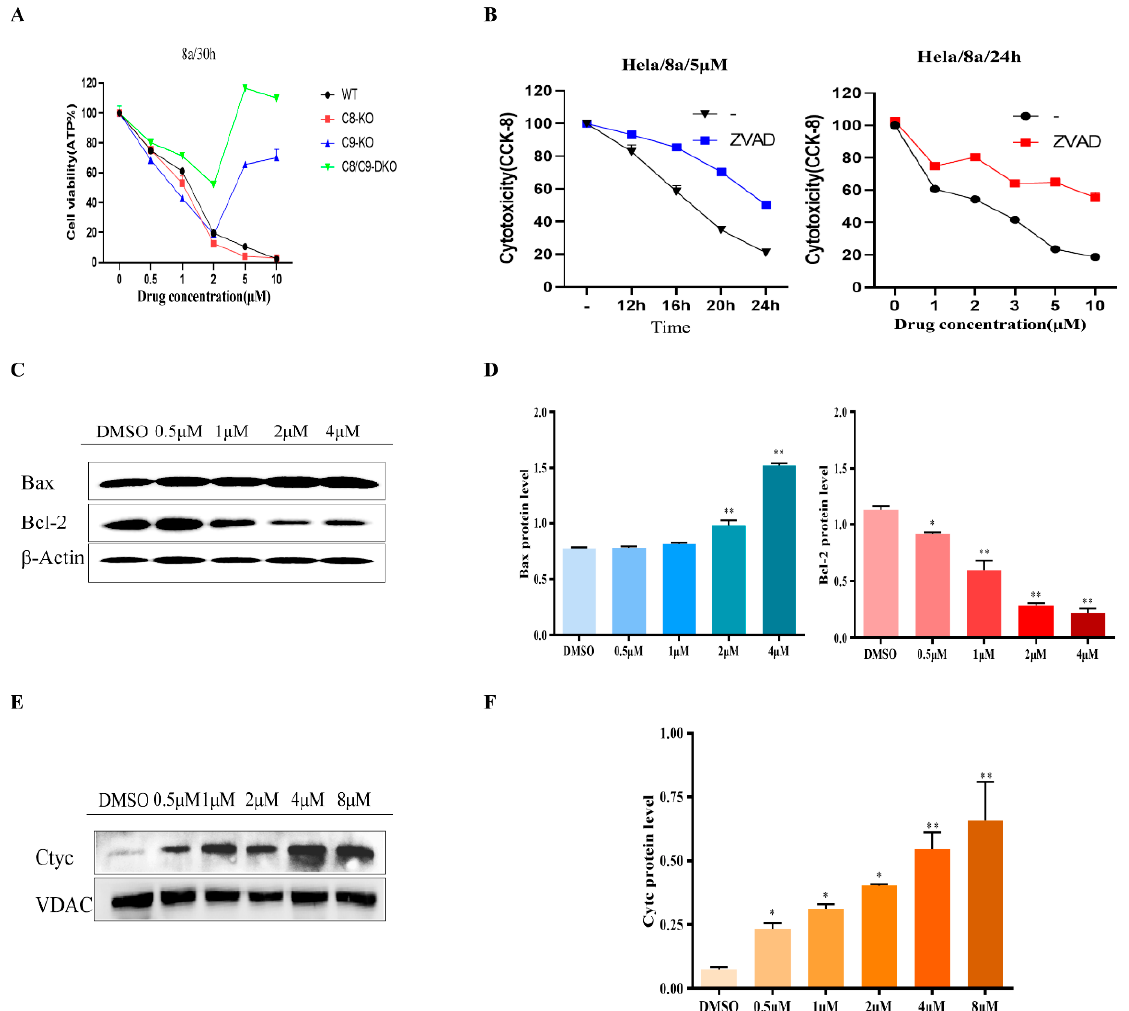
Figure 4. ( A ) 8a affects the activity of gene knockout Hela cells. caspase -8 (C8) and caspase -9 (C9) knockdown cell lines were treated with 5 μ M of 8a for 30 h; cell viability was found by measuring adenosine 5 ′ -triphosphate (ATP). ( B ) U937 cells were treated with Z-VAD-FMK and then treated with different concentrations of 8a (0, 1, 2, 3, 5, and 10 μ M) for 24 h. Another experiment used 5 μ M of 8a for different periods of time (12, 16, 20, and 24 h), respectively. Cell activity was determined by CCK8 assay. ( C , D ) Basal expression of apoptotic protein markers in 8a -treated U937 cell lines. U937 cells were treated with different concentrations of 8a (0.5, 1,2, 5, and 10 μ M) for 48 h. Protein was extracted and Western blotted with antibodies against Bax, Bcl-2 and β -actin. 0.1% DMSO was used as a negative control. Western blots were quantified, and data are presented as means ± SD of three independent experiments ( n = 3) (* p < 0.05, ** p < 0.01). ( E , F ) U937 cells were treated with different concentrations of 8a (0.5, 1,2, 5, and 10 μ M) for 48 h. Protein was extracted and Western blotted with antibodies against Cyt C, and VDAC. 0.1% DMSO was used as a negative control. Western blots were quantified, and data are presented as means ± SD of three independent experiments ( n = 3) (* p < 0.05, ** p < 0.01).